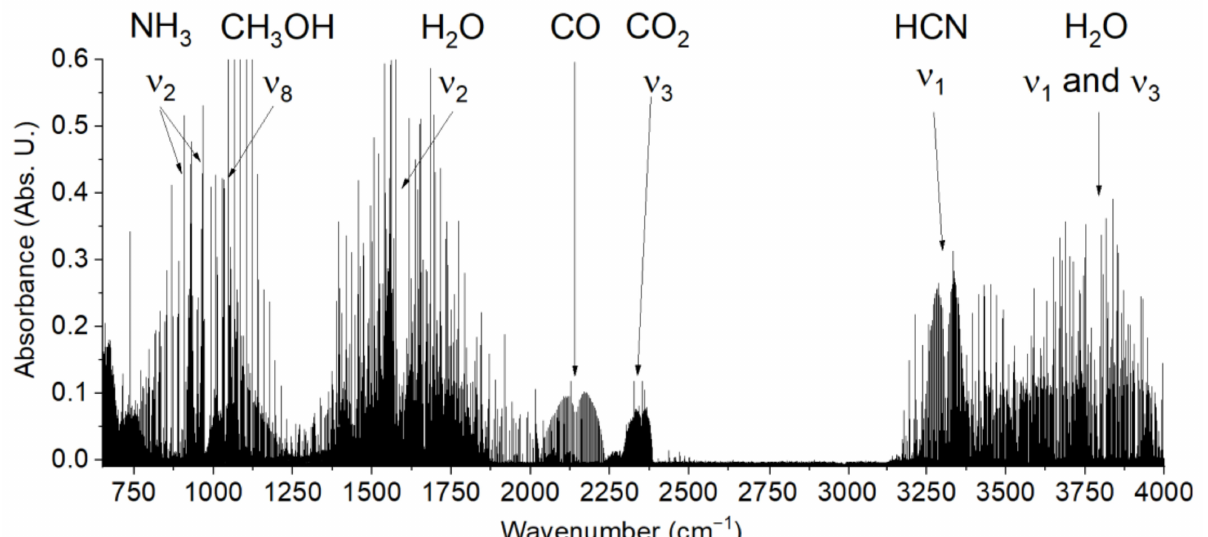
Figure 4. Infrared spectrum of gas phase thermal decomposition products of